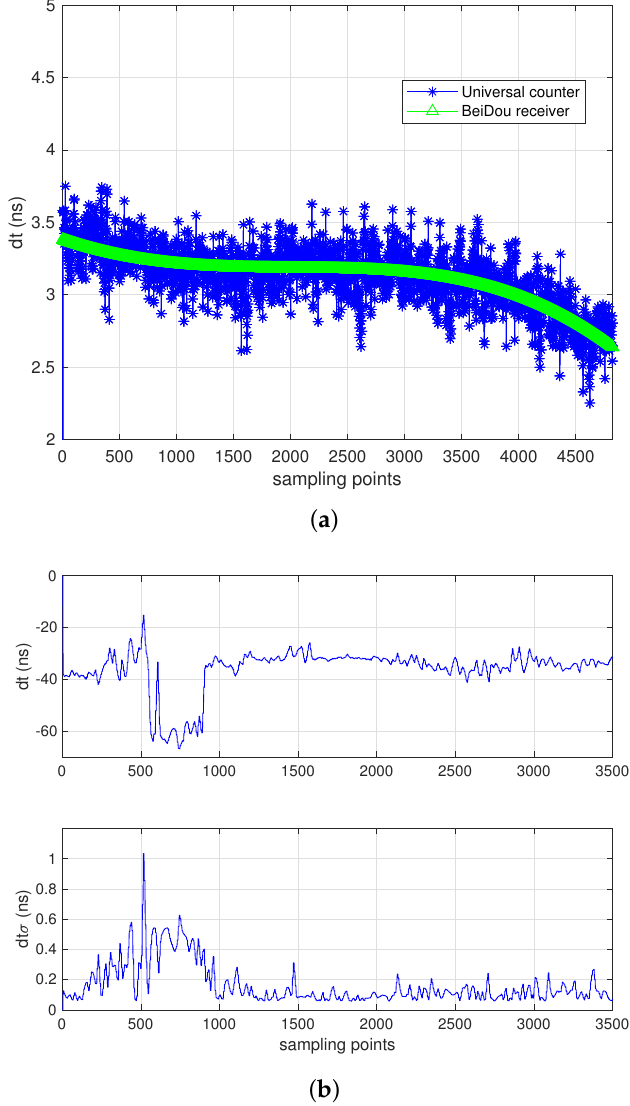
Figure 7. Performance of time synchronization test. ( a ) inter-satellite time synchronization error within 0.1 ns in static test. ( b ) inter-satellite time synchronization error within 0.1 ns in 5 µ m/s longitudinal dynamic